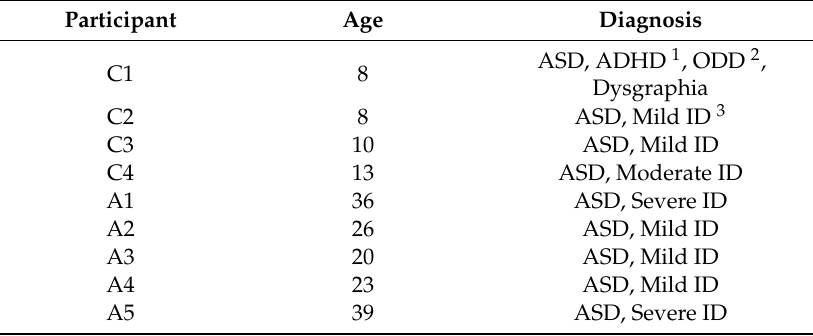
Table 1. Participants’ demographic